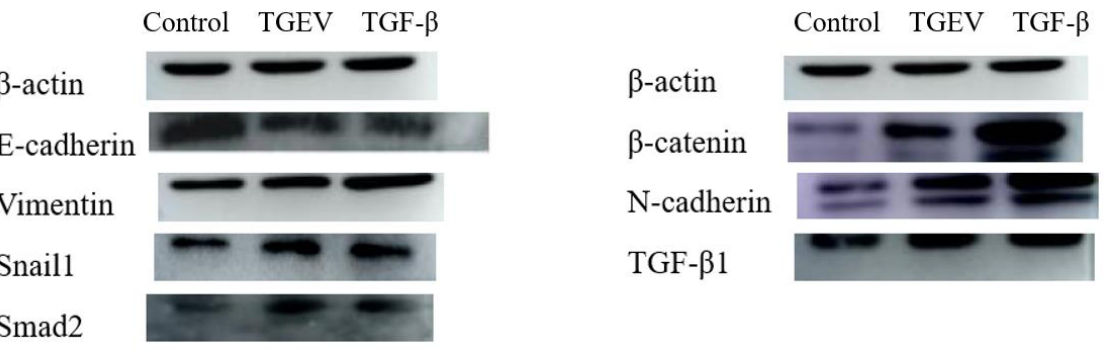
Figure 4. Western blot analysis of EMT markers.